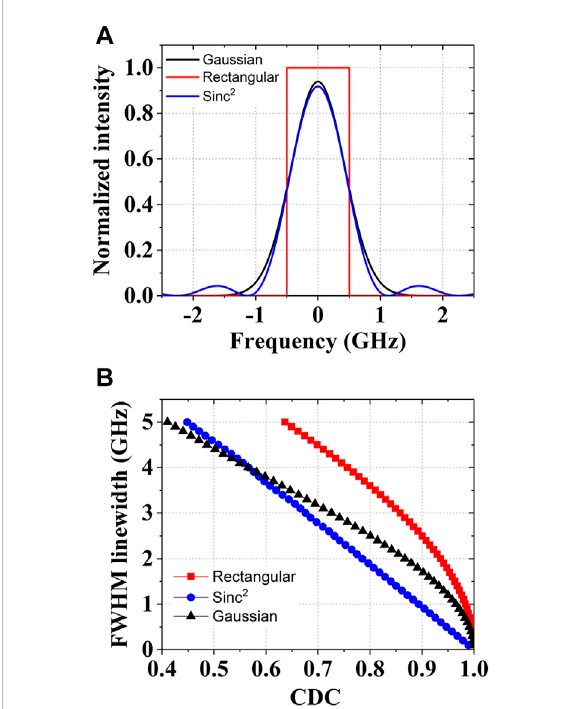
FIGURE 1 (A) theoretical spectra with rectangular, Gaussian and sinc 2 shapes, (B) the FWHM linewidths under different CDC values at 0.1 ns delay